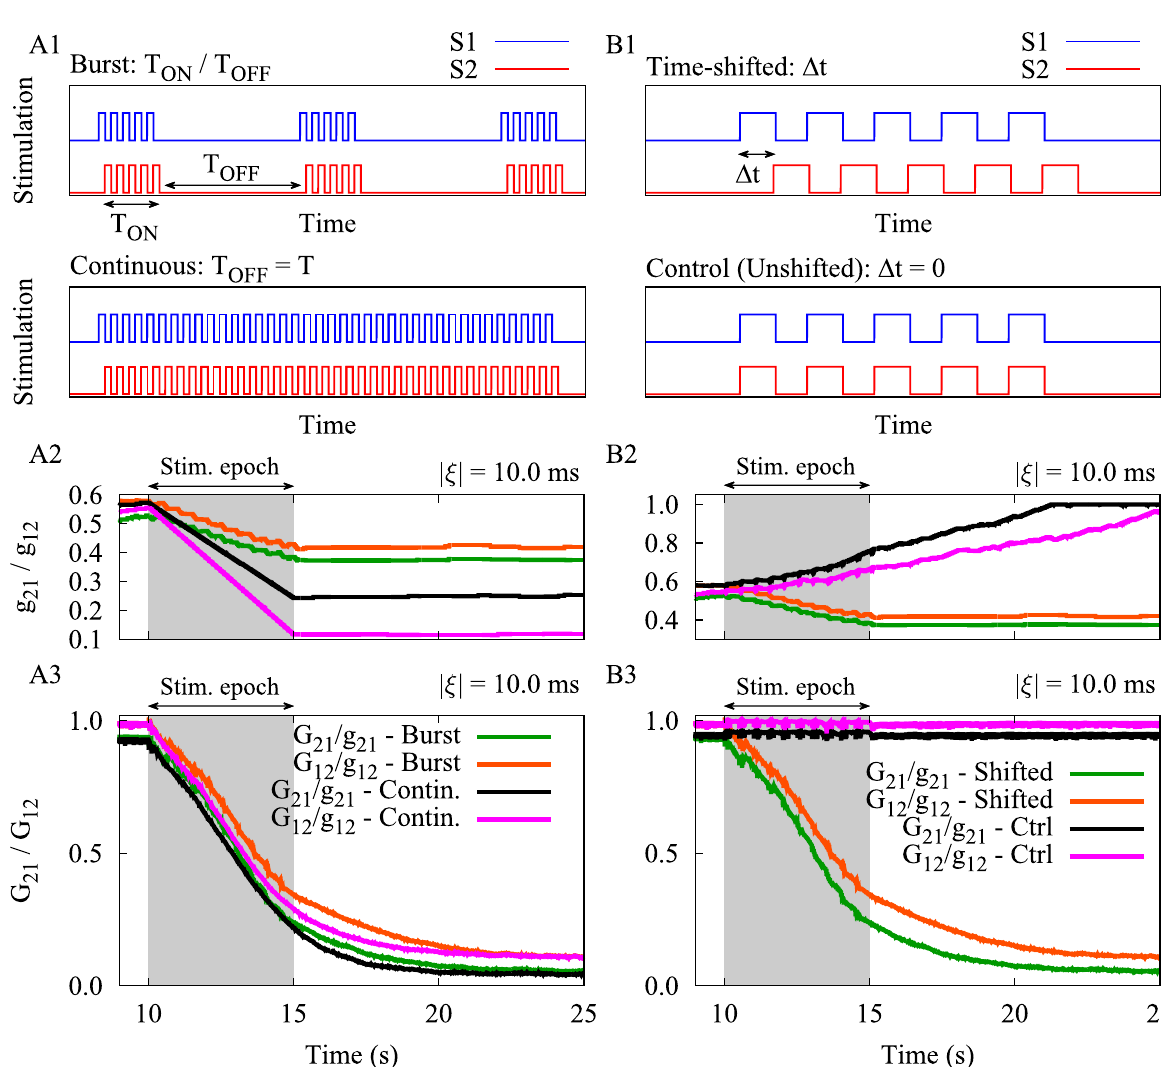
Fig 6. The effect of stimulation pattern on the stimulation outcome. ( A1 ) Burst stimulation pattern (top) vs. continuous stimulation pattern (bottom) with the same frequency and time shift between the two signals (i.e., ν = 33.3 Hz and Δ t = 5 ms). ( A2,A3 ) Time course of the synaptic strengths in the two-neuron motif ( g 21 / g 12 ) and the inter-population mean coupling between two modules in the network ( G 21 / G 12 ) are shown for burst and continuous patterns delivered to each module for | ξ | = 10.0 ms. ( B1 ) Time-shifted stimulation (top) vs. control coincident stimulation (bottom) with the same frequency ( ν = 33.3 Hz). ( B2,B3 ) Same as A2 and A3, but for the burst stimuli delivered with and without time shift. The highlighted area indicates the stimulation epoch. STDP parameters were A + = 0.008, A − = 0.005, τ + = 10 ms and τ − = 20